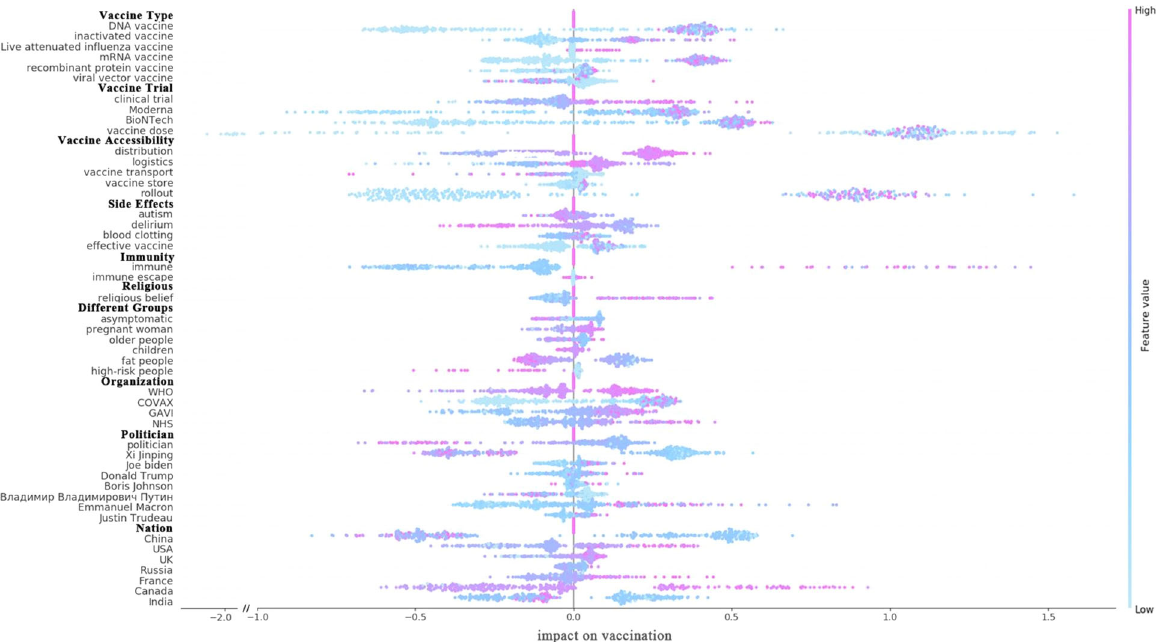
Fig. 2 The contributions of different dimensions to vaccination topics by SHAP model. We fi rst retrieved 2.3 thousand pieces of metadata containing all data from 31 December 2019 to 19 April 2021 from Google Trends. Then, we utilized the SHapley Additive exPlanations (SHAP) model to estimate the importance and impact of different dimensions on vaccination topics, which is the abscissa axis. The feature value bar on the right represents the true value of different dimensions shown on the left (see the